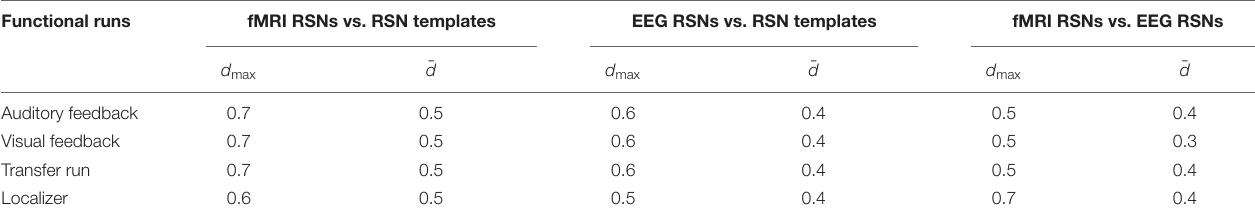
TABLE 1 | Dice coefficients between the fMRI and EEG RSNs and RSN templates from Smith et al. (2009), and between the RSNs derived from fMRI and EEG-ESI data, for each run separately. Functional